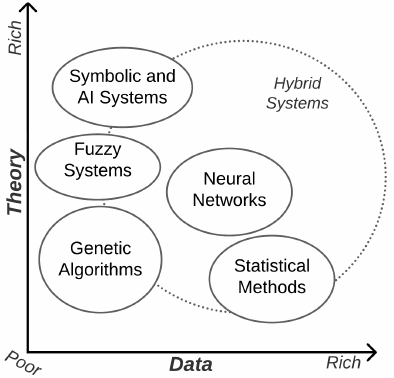
Figure 3. Usability of different methods for problem-solving depending on availability of data and expertise (theories) on a problem